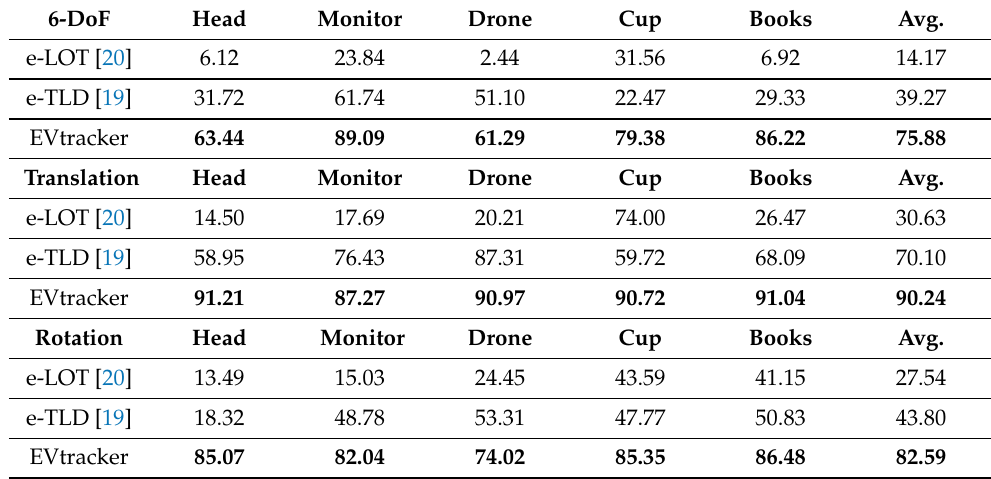
Table 3. Comparison to recent SOTA algorithm e-LOT [20] and e-TLD [19] using the Success Plot Met- ric, and the best results are highlighted